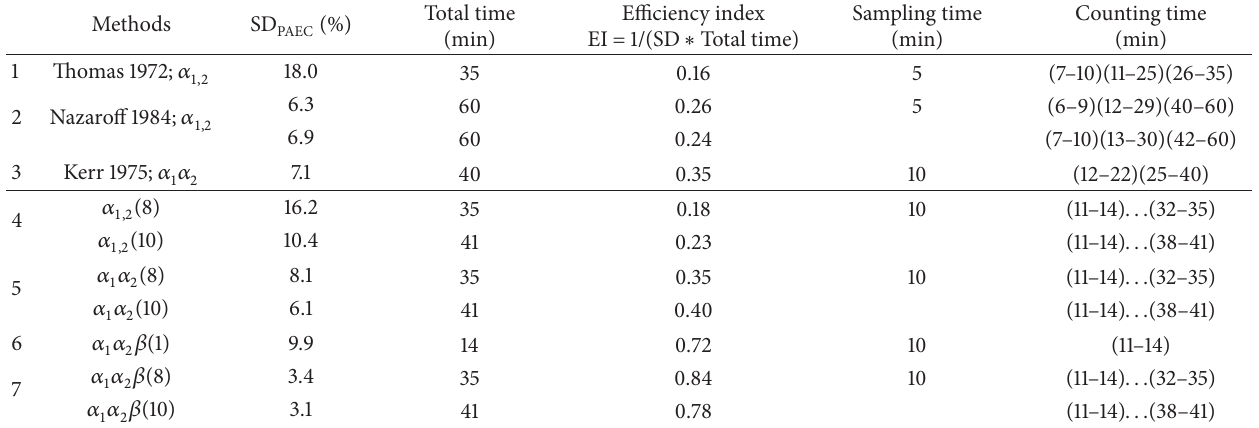
Table 1: Efficiency analysis of different radon progeny measuring methods.